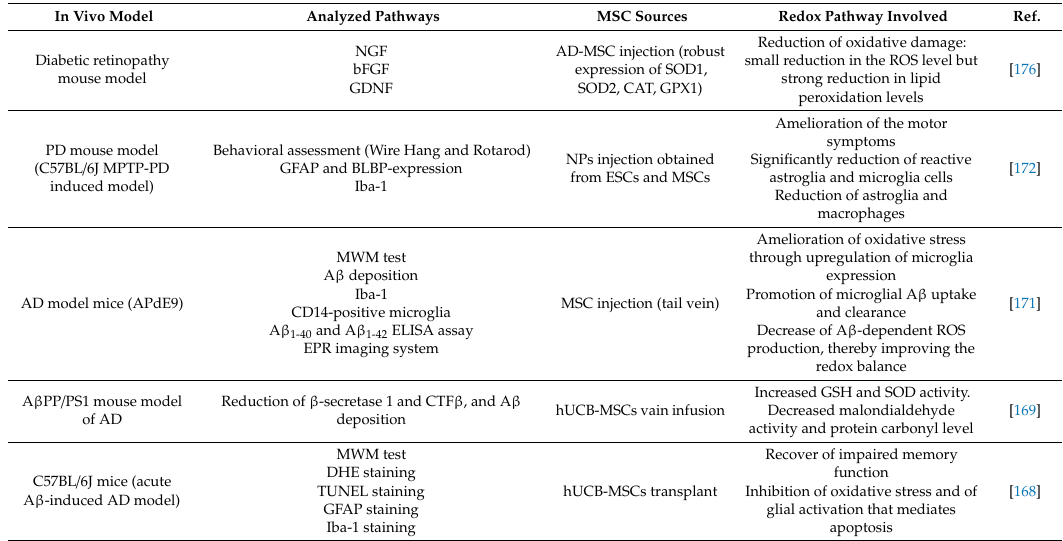
Table 3. MSC studies on in viivo models of neurodegenerative diseases.